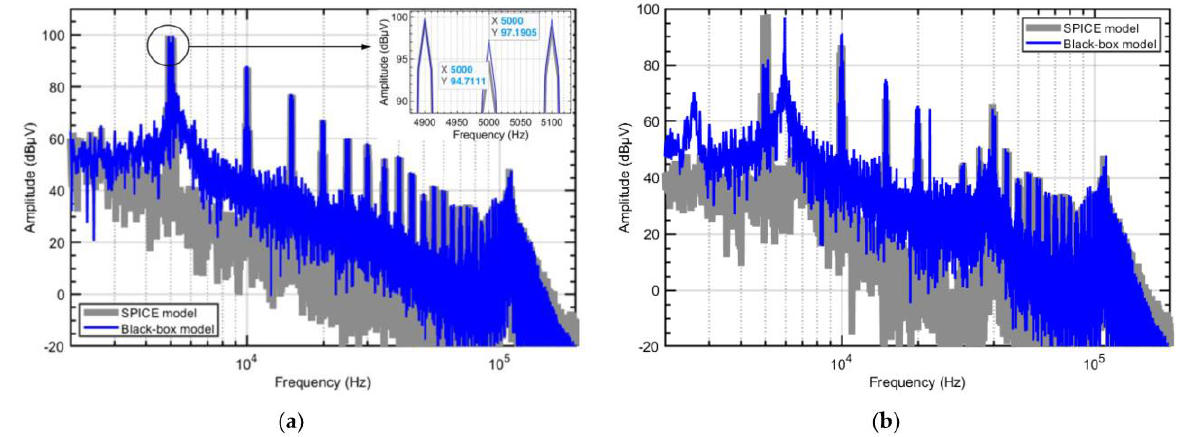
Figure 16. CE levels predicted by exploiting two different LISNs, i.e., ( a ) CISPR16 and ( b ) CISPR22 LISN: SPICE versus black-box model.